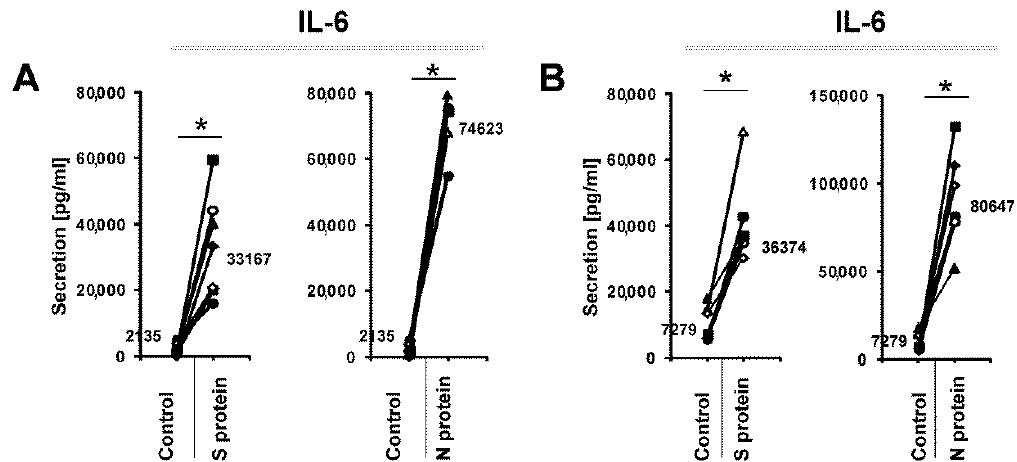
Figure 4. IL-6 production in the cellular supernatants of human monocytes ( A ) and macrophages ( B ) cultured in the presence of 1 μg/mL SARS -CoV-2 proteins S (spike) and N (nucleocapsid) was determined using the human IL-6 Quantikine ELISA Kit. Control cells were treated with an equal volume of PBS. The data show individual values for seven independent donors ( n = 7), and straight lines connect the control value and the value after SARS-CoV-2 protein treatment from individual donors. The median values are also shown in the figures. An asterisk indicates a statistically significant difference at p < 0.05.